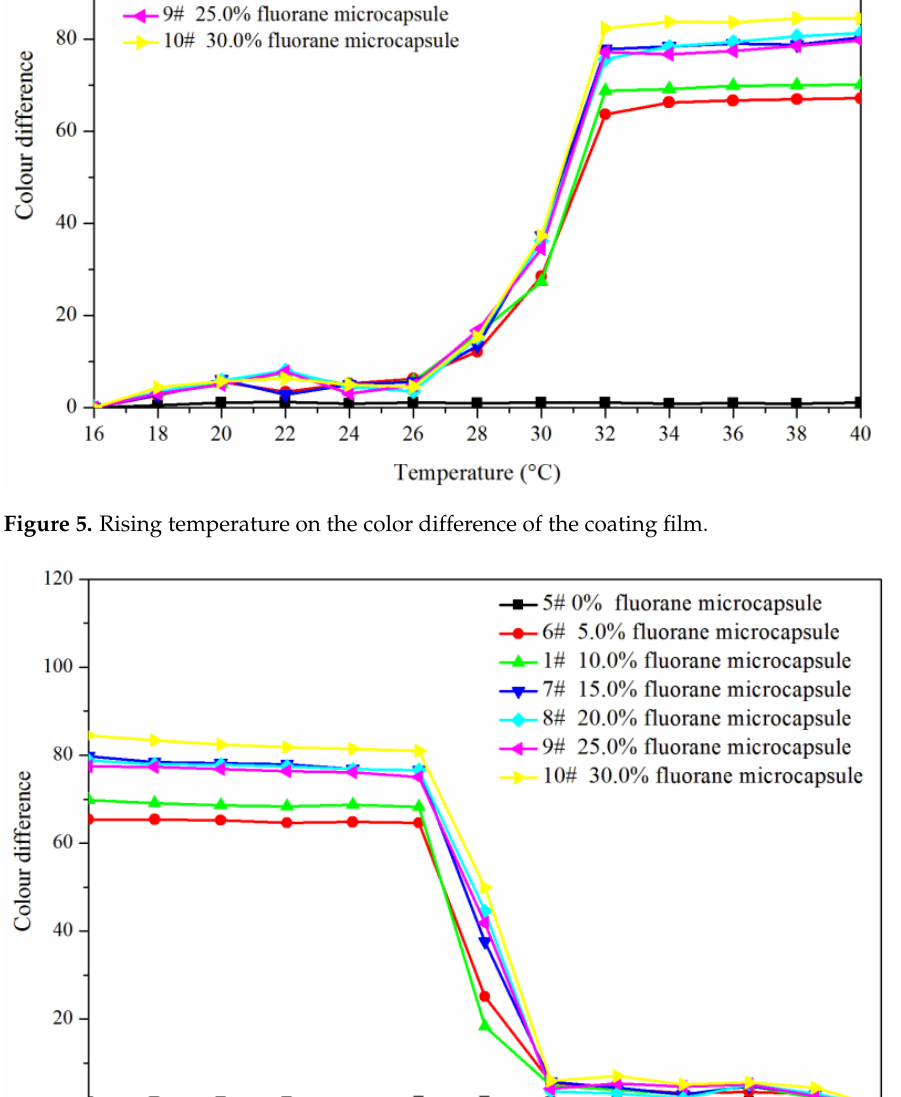
Figure 6. Falling temperature on the color difference of the coating film.